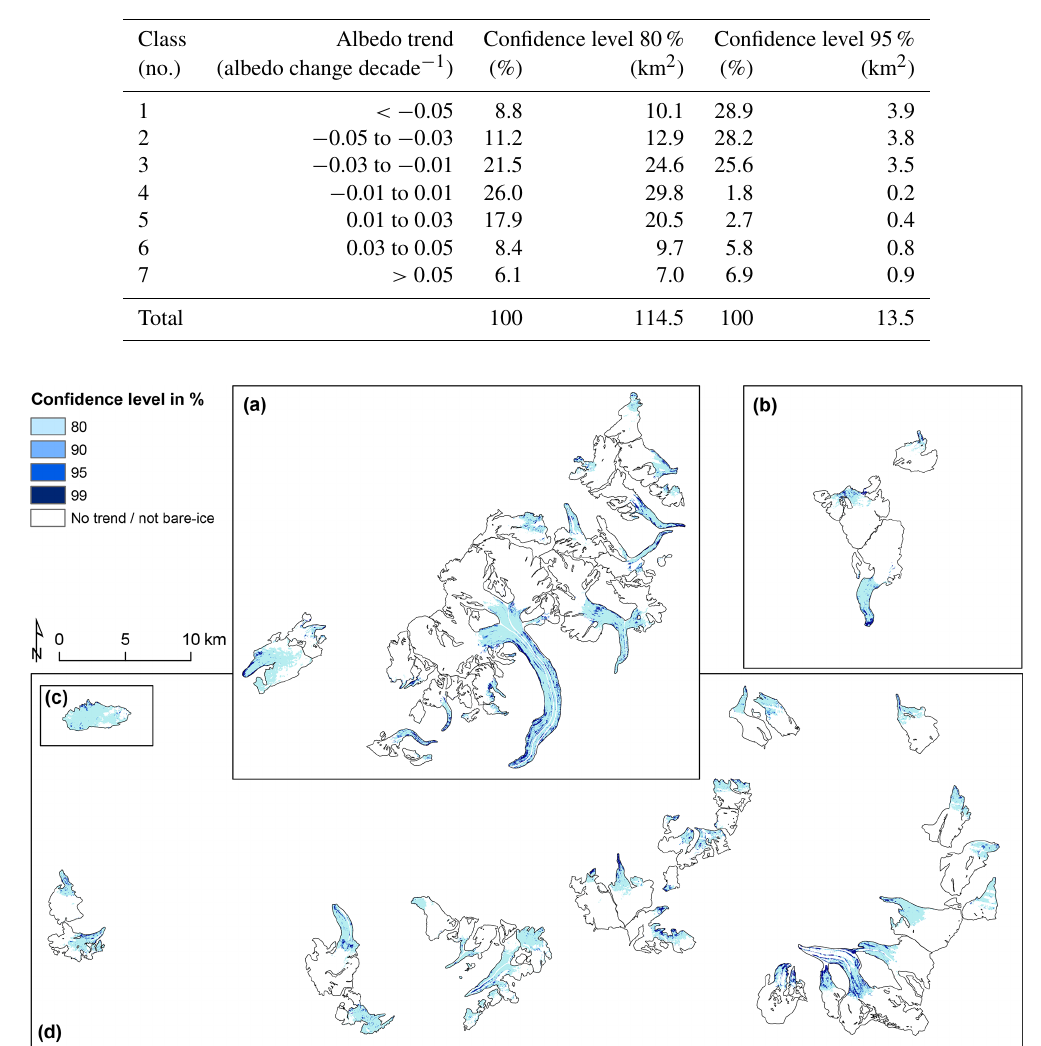
Table 4. Overview of classes of bare-ice albedo trends for individual grid cells between 1999 and 2016 corresponding to the confidence levels of 80% and 95% according to the MK test. Numbers refer to the sum of all bare-ice grid cells of all 39 study glaciers.